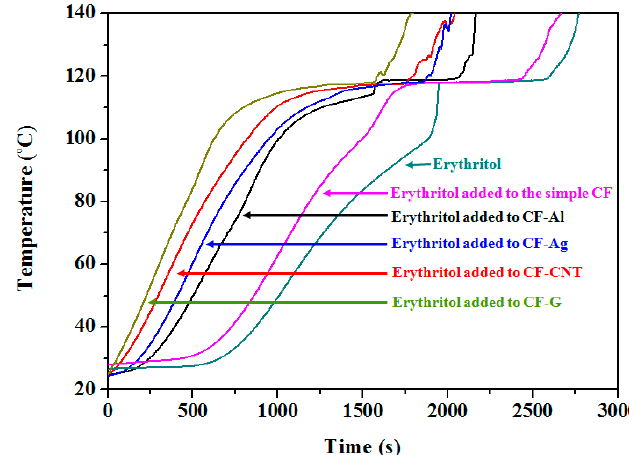
Figure 3. Temperature changes with time of erythritol and erythritol added to the simple CF and CF containing various nano thermal conducting materials.